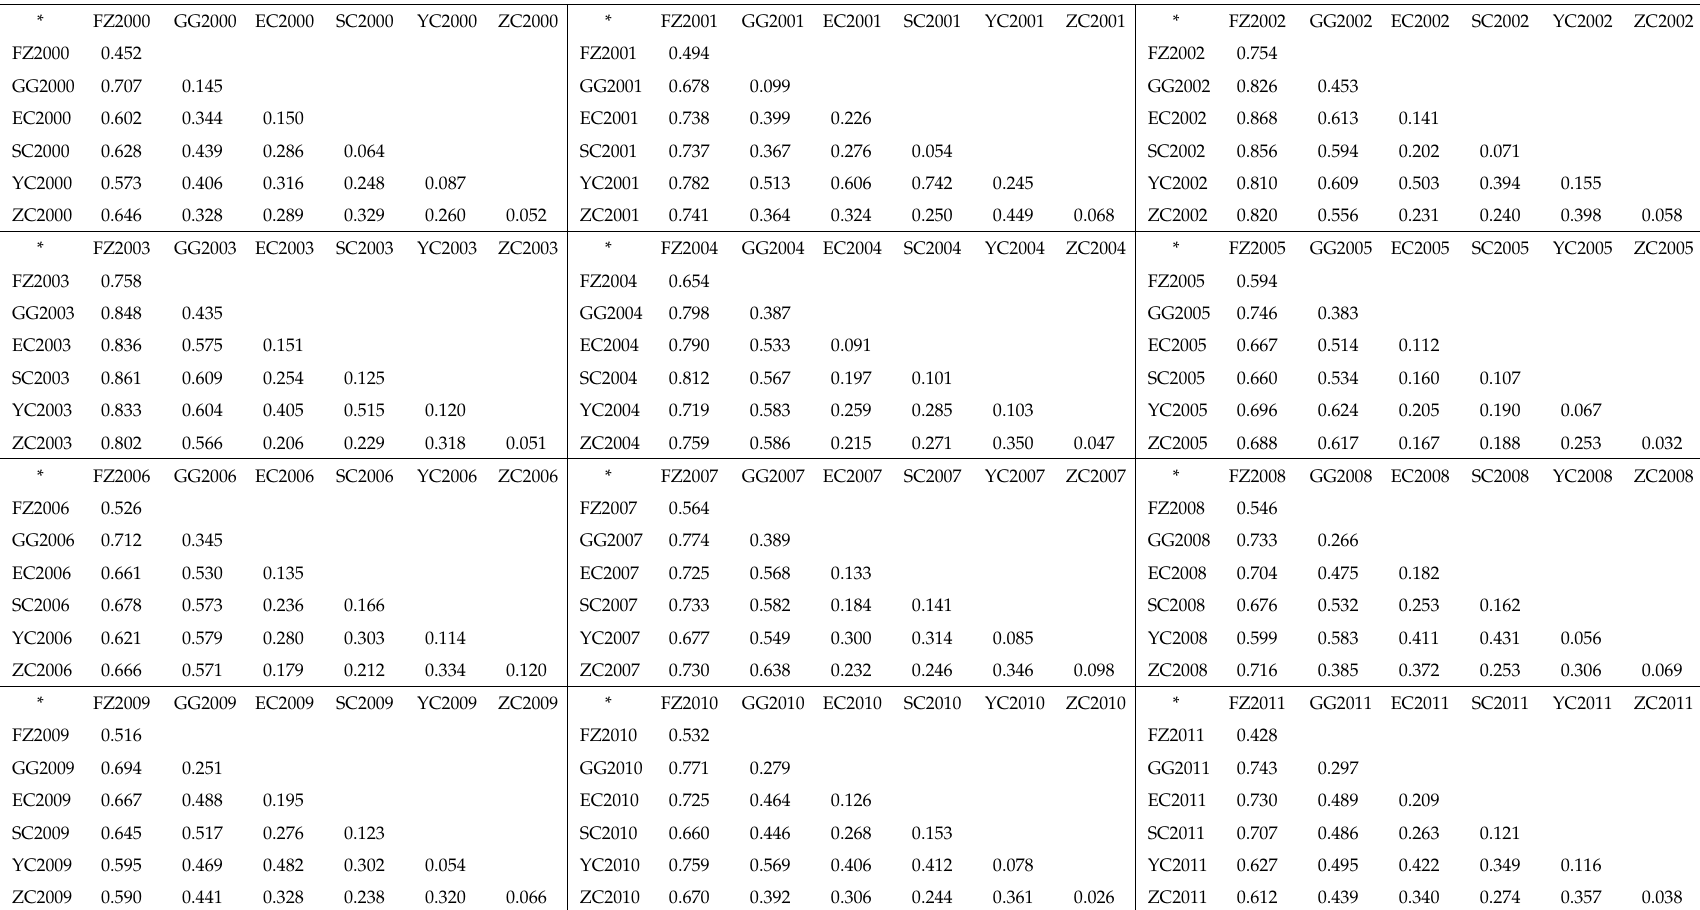
Table 8. Interaction results of di ff erent factors on the agriculture land-use intensity in Hubei Province from 2000 to